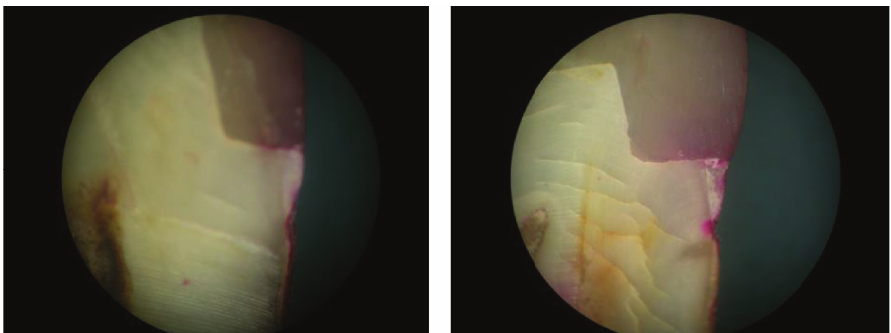
Figure 7: Group 4: microleakage seen under composite restorations with RMGIC